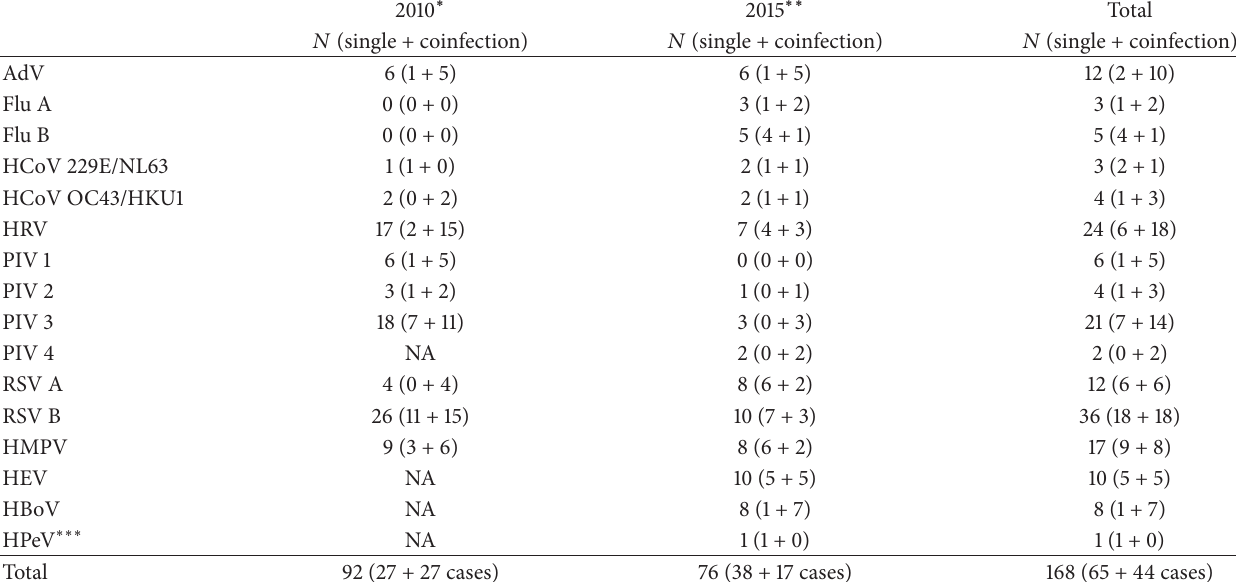
Table 2: Viral etiology and coinfections identified in 109 infected children in two respiratory